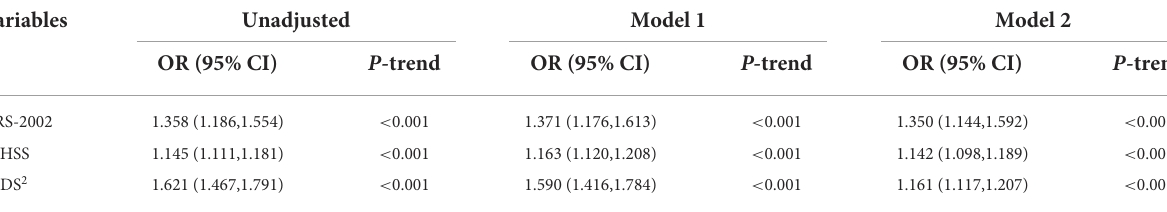
TABLE 2 Adjusted ORs (95% CI) for the association of NRS-2002, NIHSS, and A 2 DS 2 scores with the incidence of stroke-associated infection. Variables Unadjusted Model 1 Model